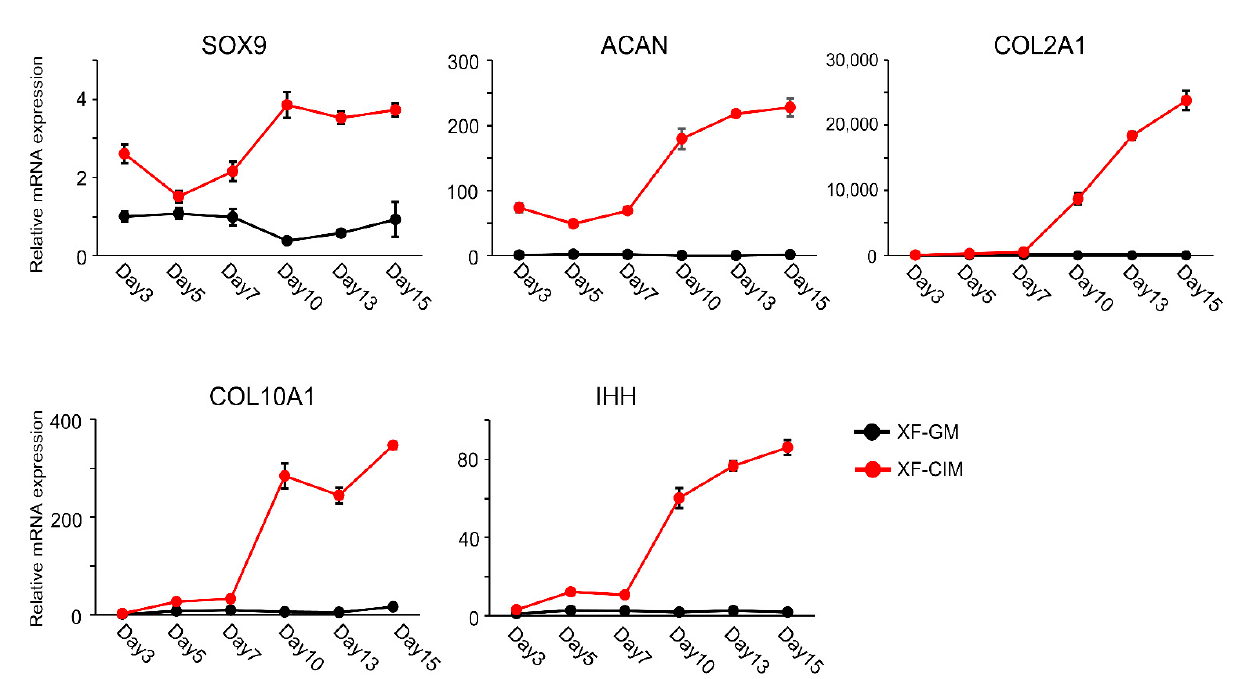
Figure 2. C-MSCs generated with XF-CIM expressed hypertrophic chondrocytes marker genes. C-MSCs were cultured in XF-GM or XF-CIM for the indicated culture period. The expression levels of chondrocyte marker genes were analyzed by real-time PCR with ∆∆ Ct method by using 18S as a reference control. Data were normalized to the values of C-MSCs maintained in XF-GM for 3 days as 1.0. Values represent means ± S.D. of three replicates of culture. The black line indicates XF-GM-treated group, and the red line is XF-CIM cultured one. All graphs are representative of four independent experiments.